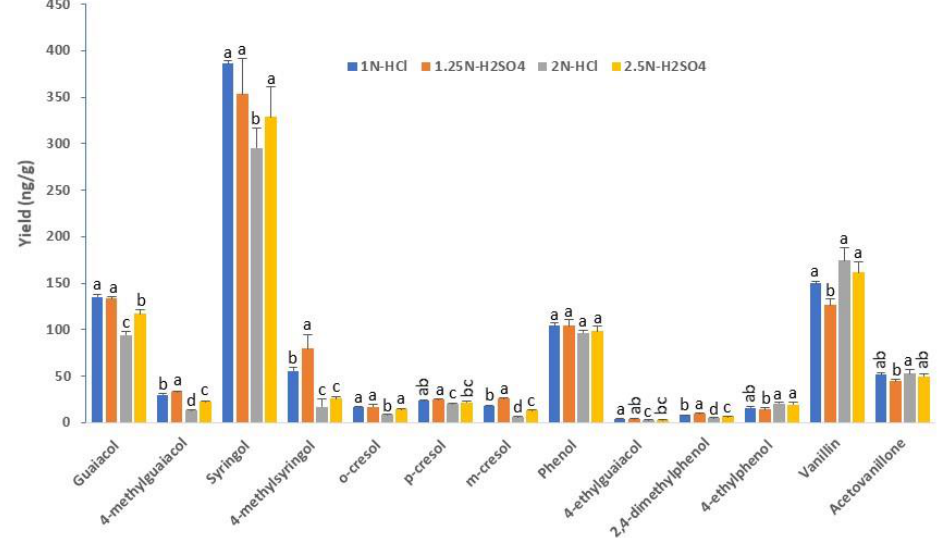
Figure 3. VP yield comparison following hydrolysis of a smoke-exposed grape sample (Shiraz) with di ff erent acids. Columns represent the mean values of three replicates and error bars are standard deviations. Within each compound, columns with di ff erent letters are significantly di ff erent ( p < 0.05). All hydrolysis reactions were conducted at 100 ◦ C for 60